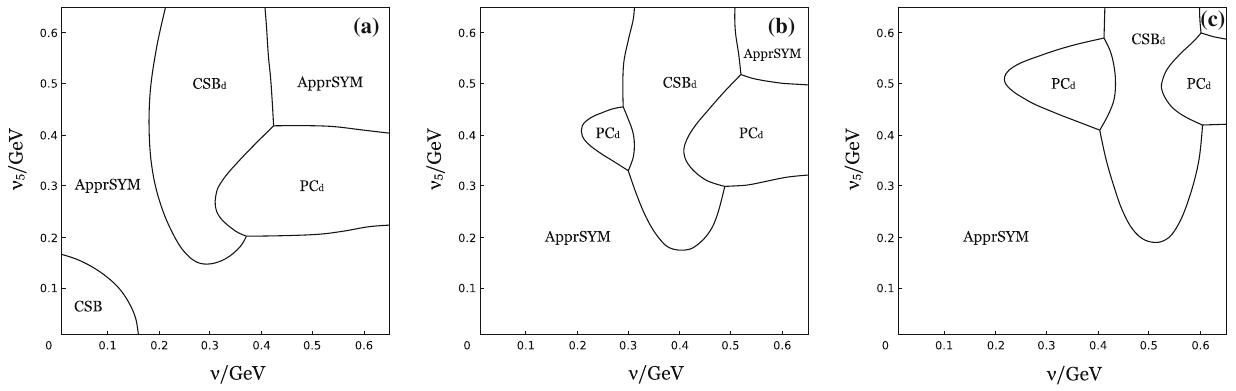
Fig. 3 The (ν,ν 5 ) -phase portraits of the model at the physical point ( m 0 = 5 . 5MeV ) and at μ = 300MeV – ( a ); μ = 400MeV – ( b ); and μ = 500MeV – ( c